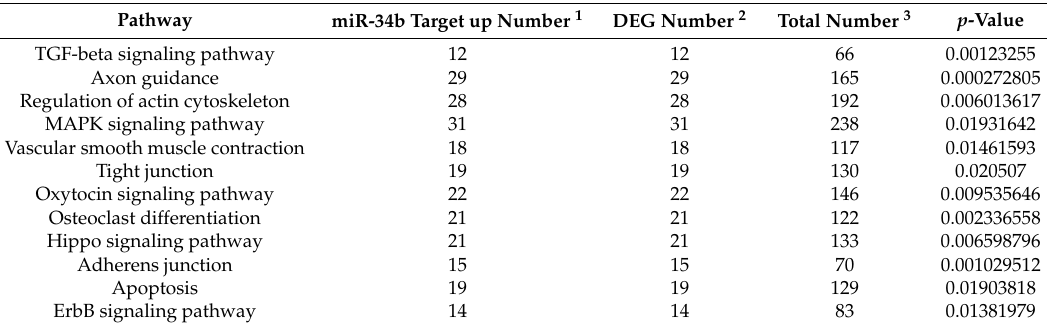
Table 1. Signaling pathways involved in miR-34b function.